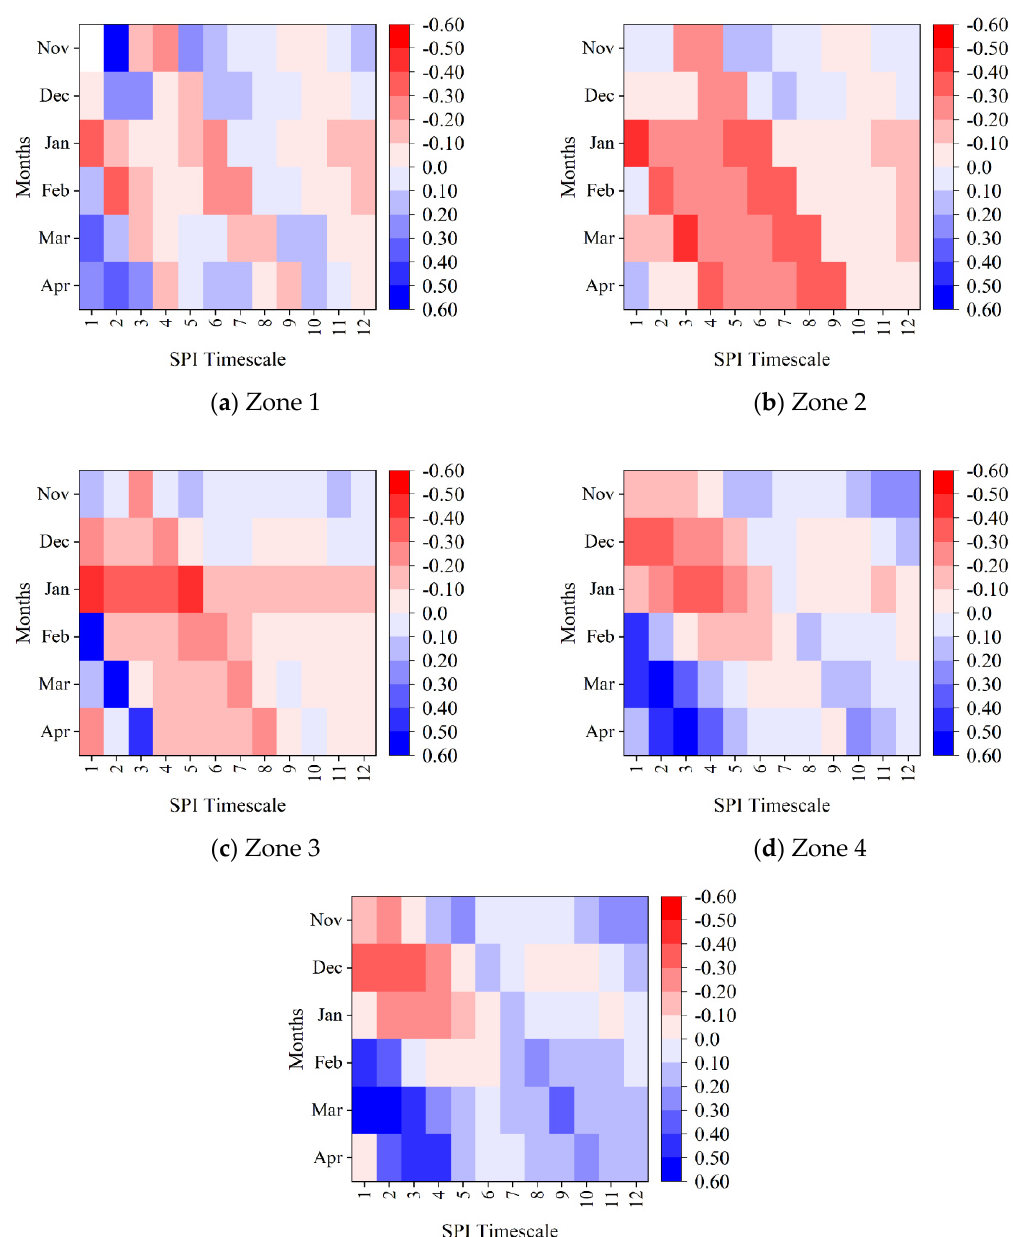
Figure 6. The correlation coefficients between the monthly Standardized Precipitation Index (SPI) series at 1–12-month lags and the Standardized Yield Residual Series ( SYRS ) of wheat in different zones of Punjab during 2001–2019, ( a ) Zone 1, ( b ) Zone 2, ( c ) Zone 3, ( d ) Zone 4 and ( e ) Zone 5. The red color indicates a positive correlation, and the blue color indicates a negative correlation.